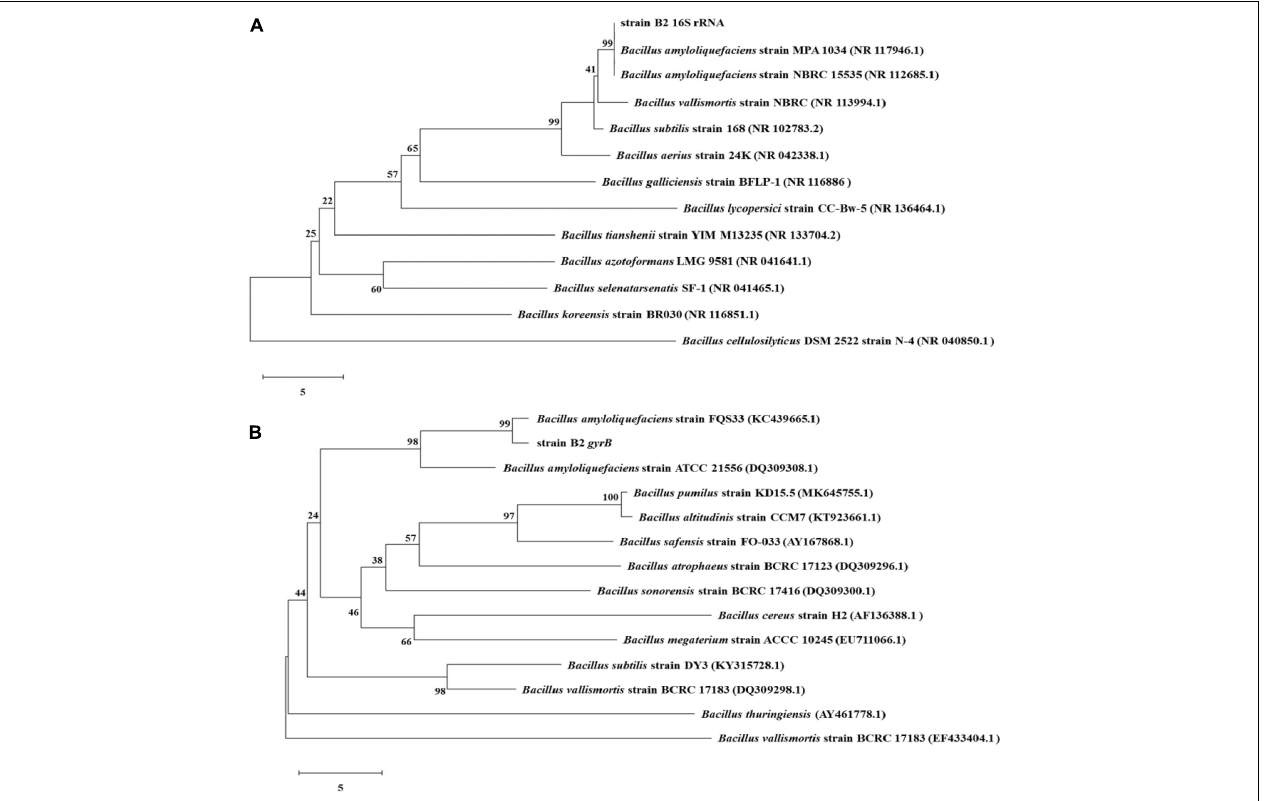
FIGURE 3 | Phylogenetic trees constructed based on 16S rRNA (A) and gyrB (B) gene sequences of B. amyloliquefaciens B2 and other Bacillus strains. Bootstrap values (%) shown at the branches were calculated from 1,000 replications.